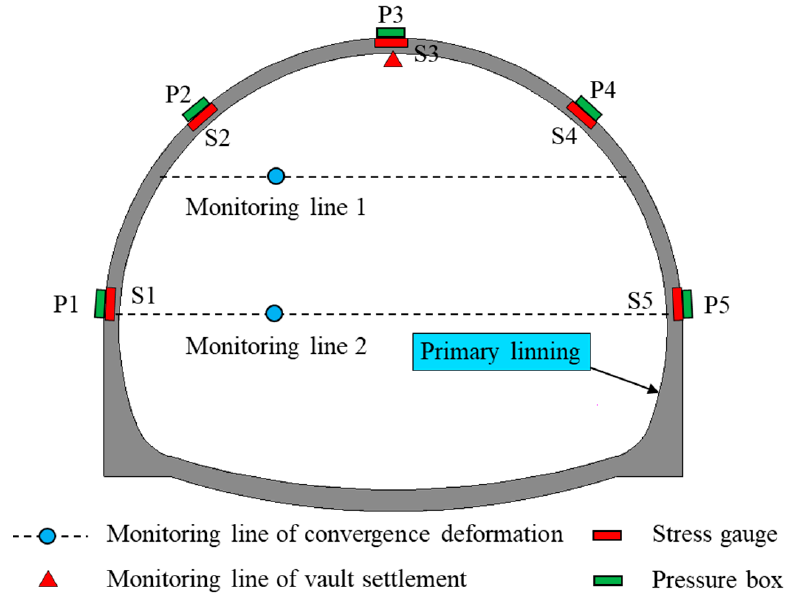
Figure 11. Layout and photographs of test elements at ZK161 + 729.